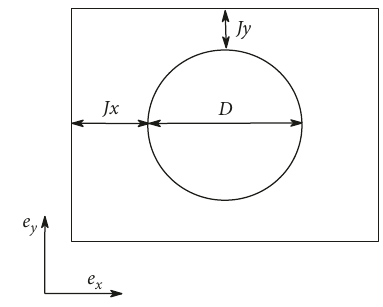
Figure 1: Confinement geometry at midplane L